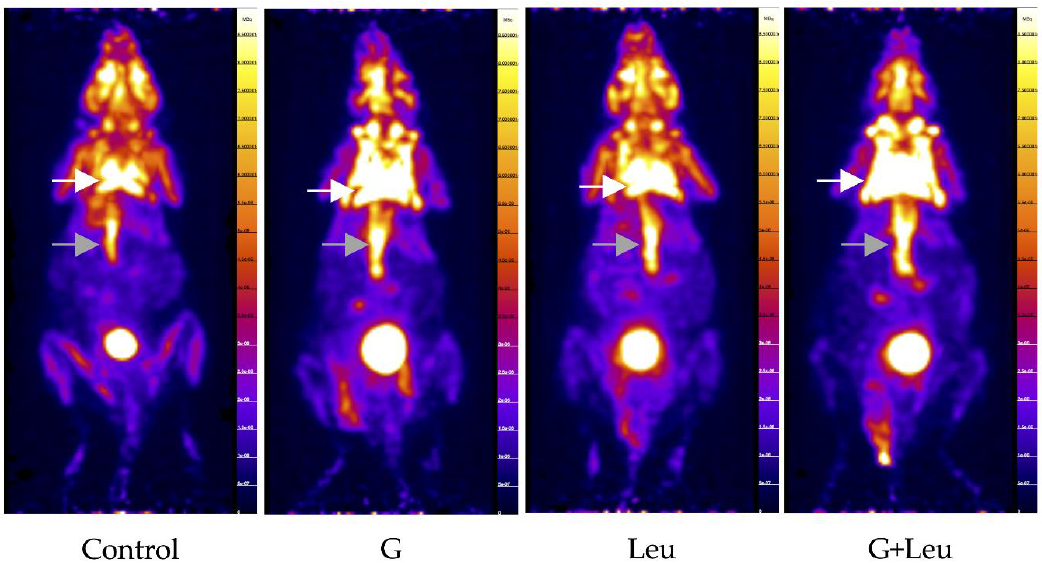
Figure 1. 2-deoxy-2-(fluorine-18)fluoro- D -glucose ( 18 F-FDG) uptake determined using positron emission tomography (PET) imaging. Representative PET scans for control, glucose (G), leucine (Leu), and the combination of G + Leu-treated mice. The white arrow indicates interscapular brown adipose tissue (IBAT) and the grey arrow indicates paraspinal skeletal muscle.